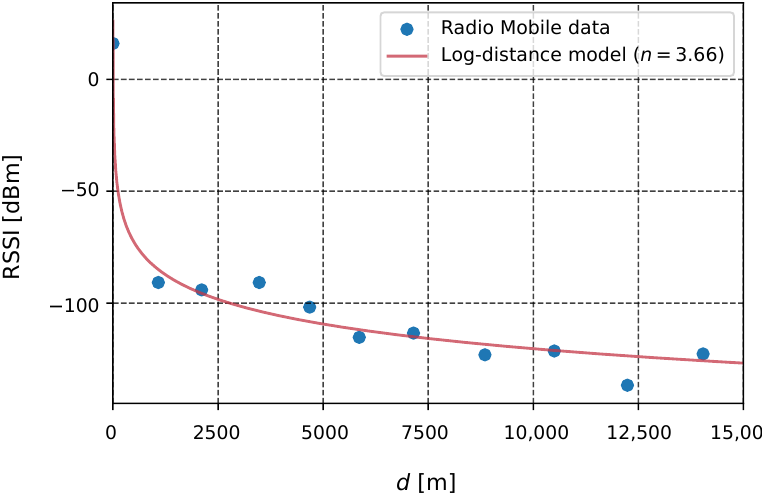
Figure 5. Received power (dBm) as a function of distance and the log-distance